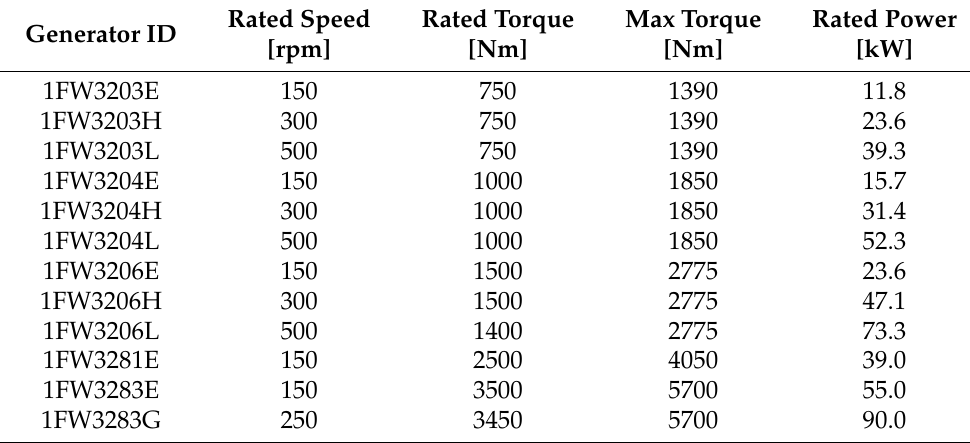
Table 2. Main features of generators included in the analysis adapted from